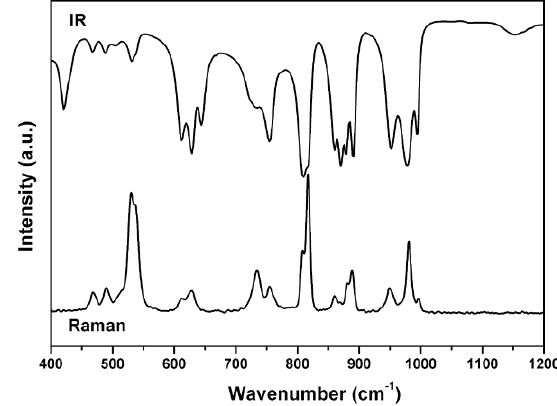
Figure 1. IR and Raman spectra of K